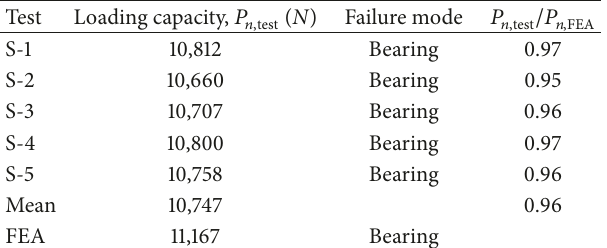
Table 3: Summary of the lap shear connection